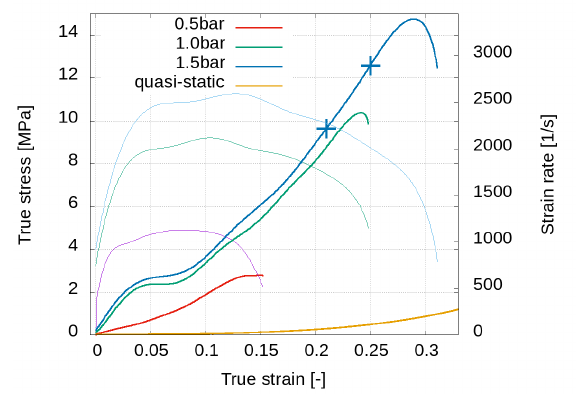
Figure 6. Stress-strain curves and strain-rate evolu- tion for group of polyurethane putty